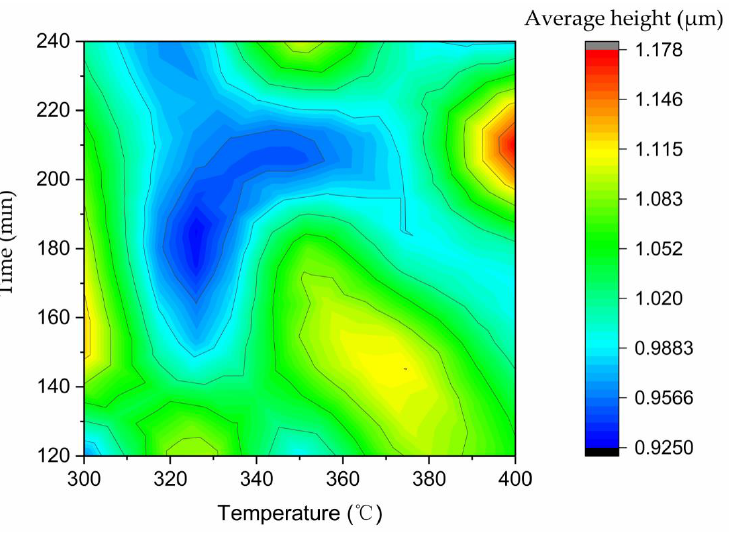
Figure 8. Effect of temperature and time on average height of active grains.